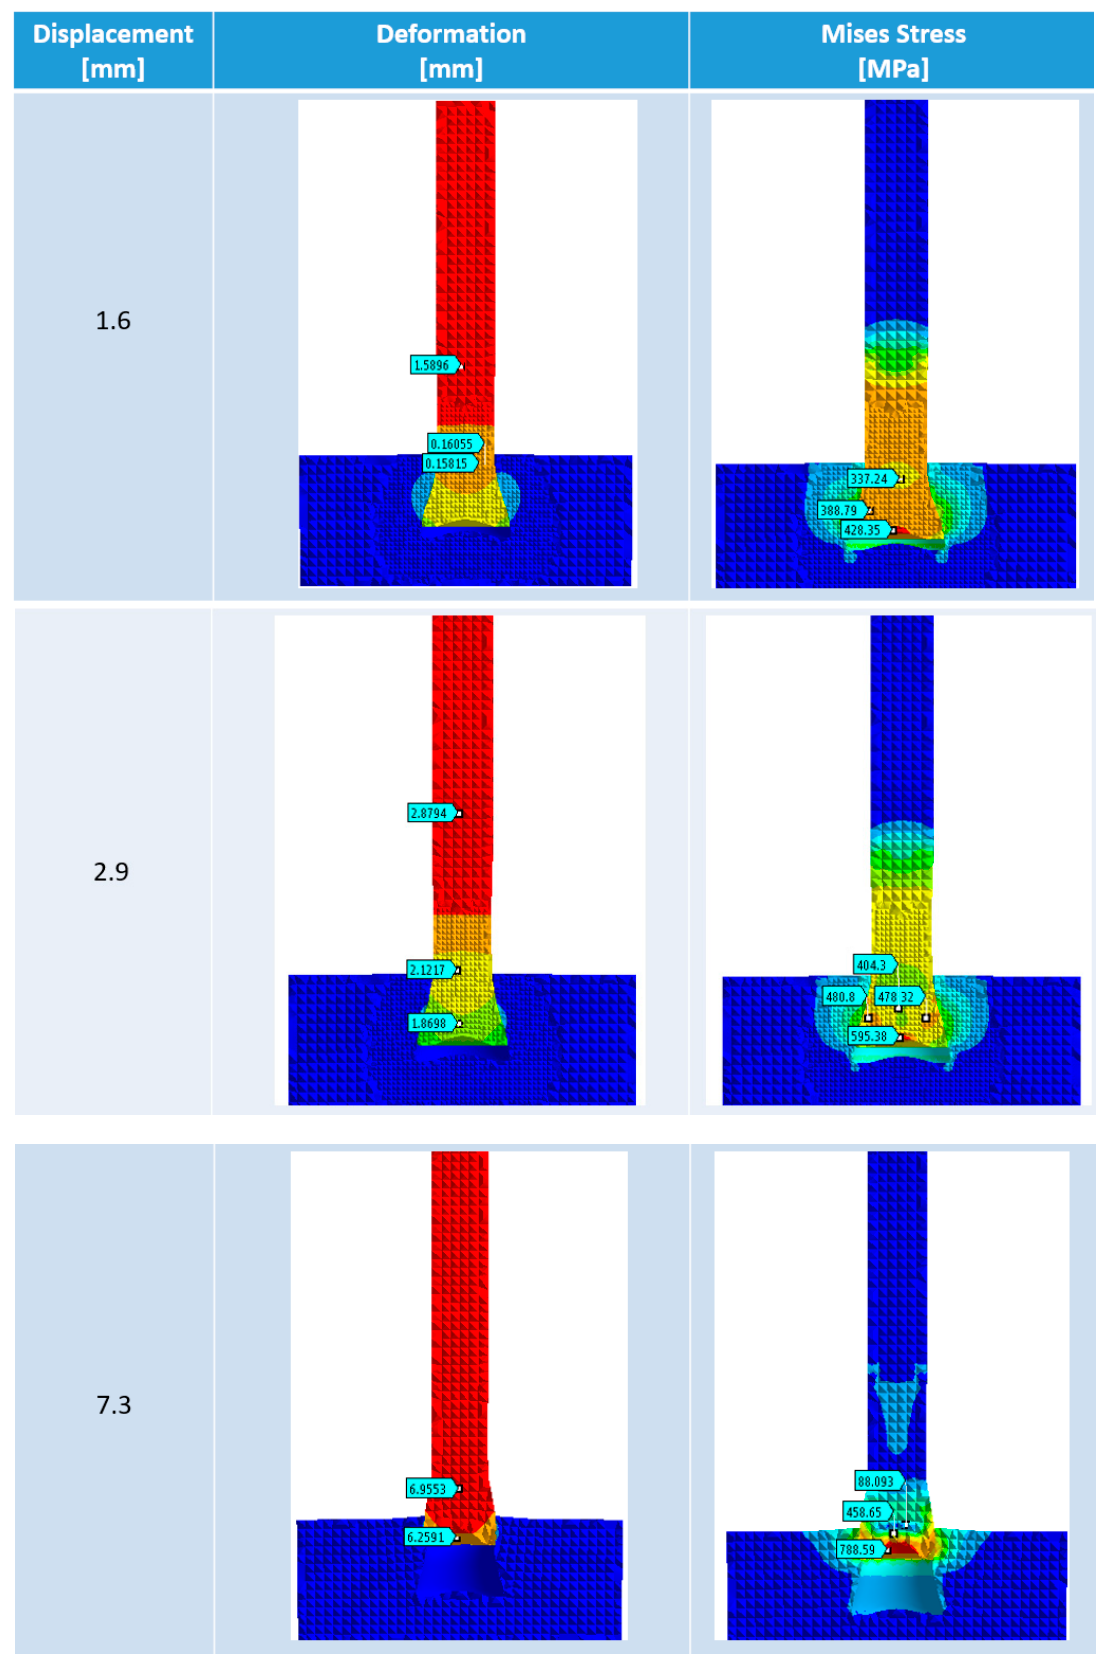
Figure 7. FE model displaying the development of Misses stresses of the friction riveted joints under tensile loading.